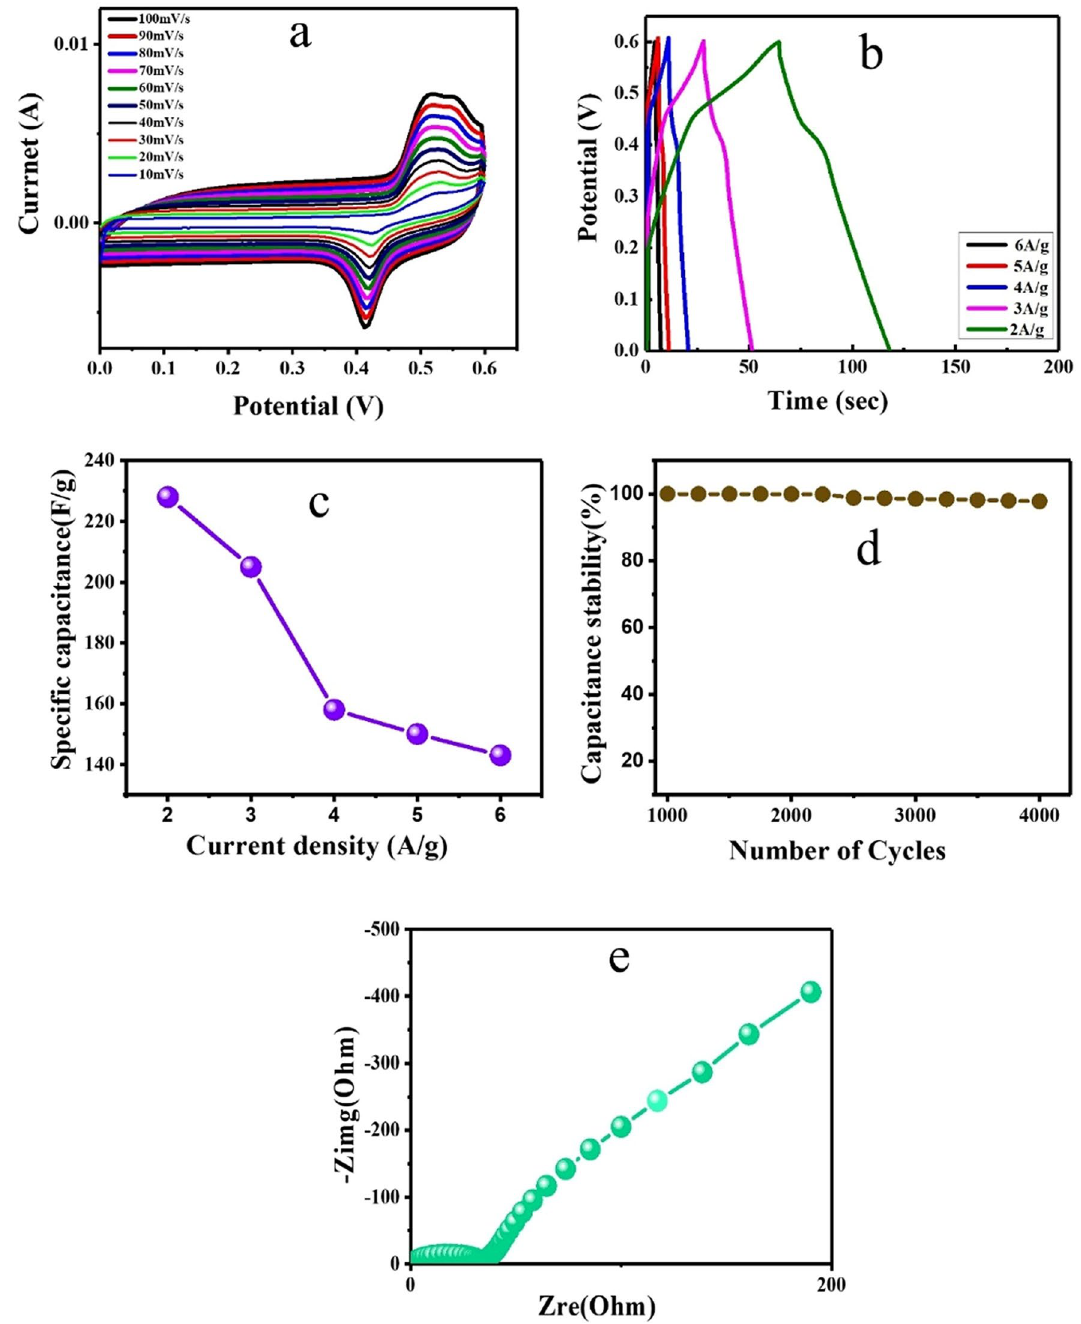
Figure 8. CV analysis of the N-MWCNT/CMC composite for the three-electrode configurations via 3 M KOH